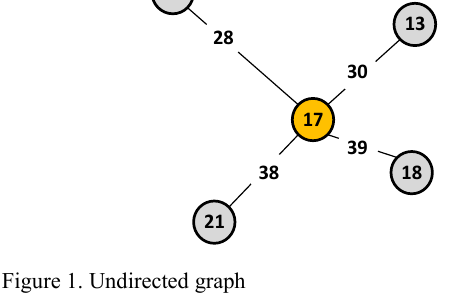
Figure 1. Undirected graph